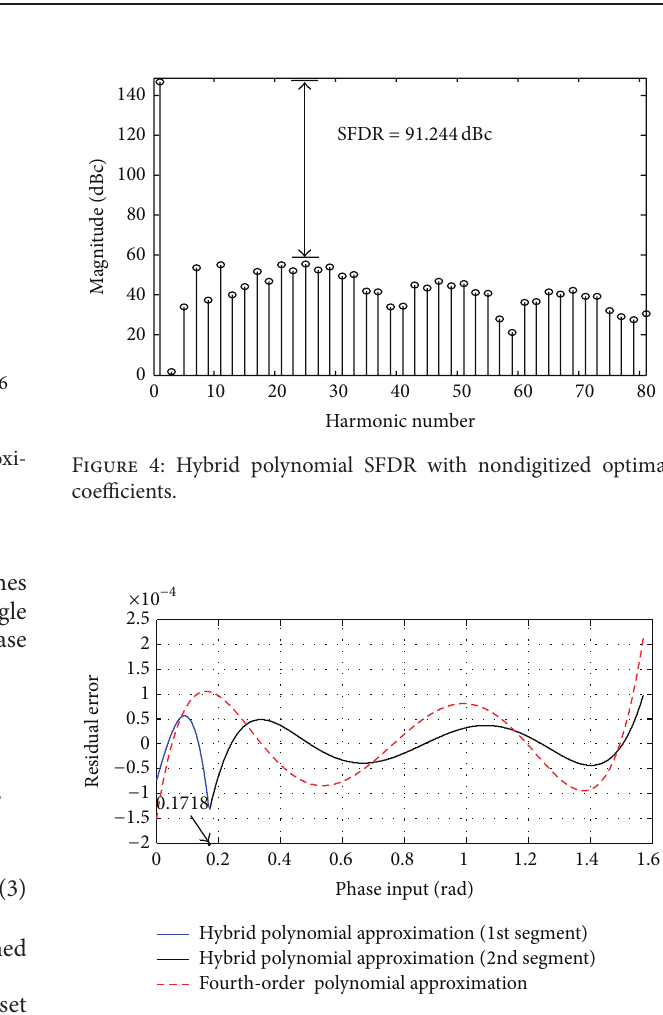
Figure 5: The residual error of the approximated sinusoidal